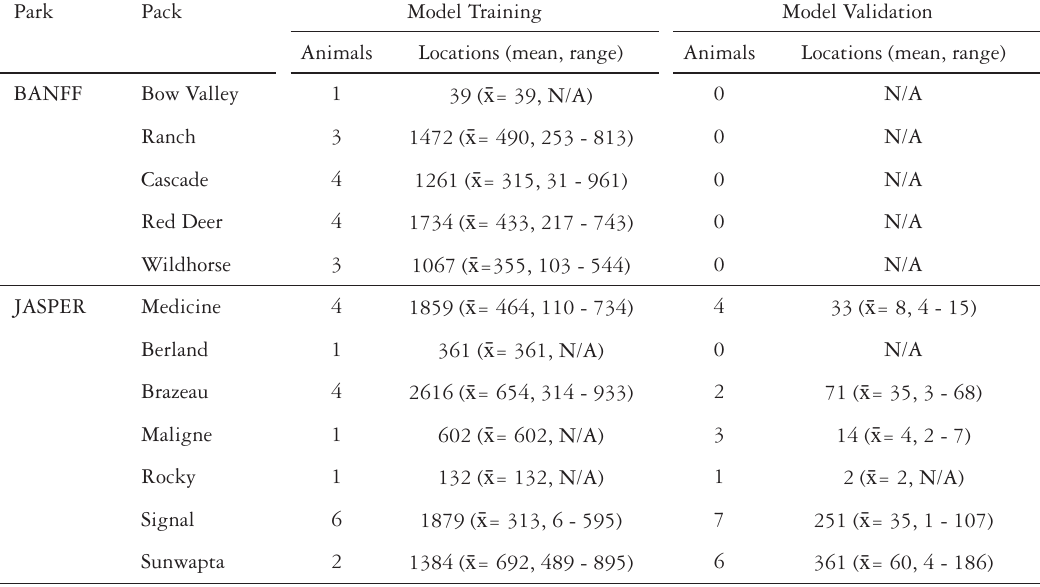
S-table 3. Number of animals from each wolf pack monitored during winter in Banff and Jasper National Parks, and total number of locations used in winter model development and validation 2002 –